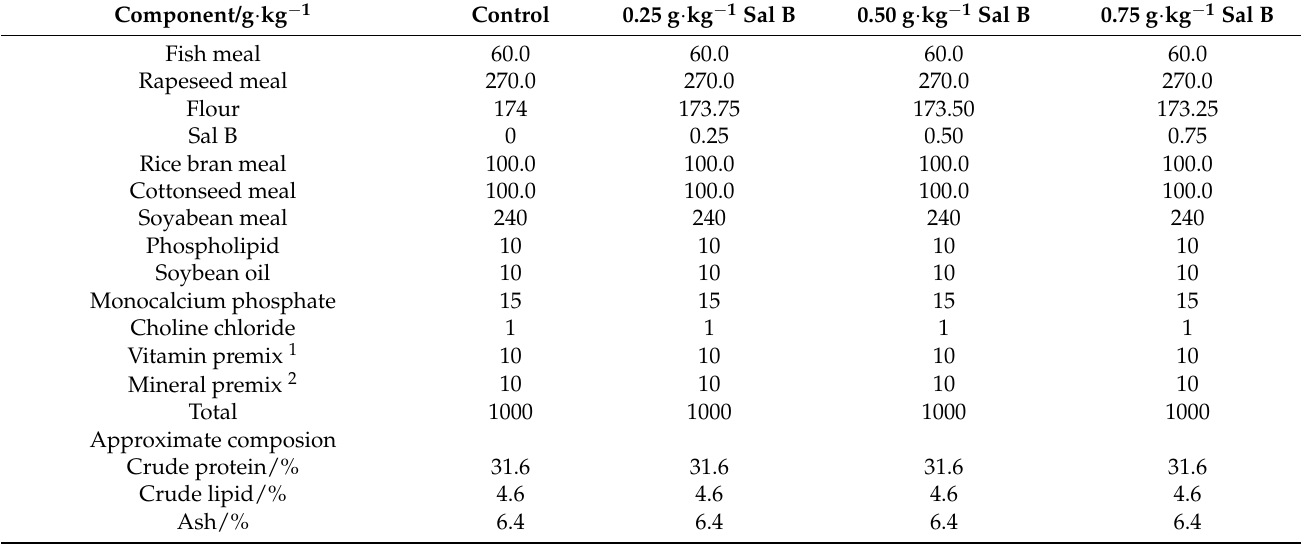
Table 1. Compositions and nutrient levels of the experimental